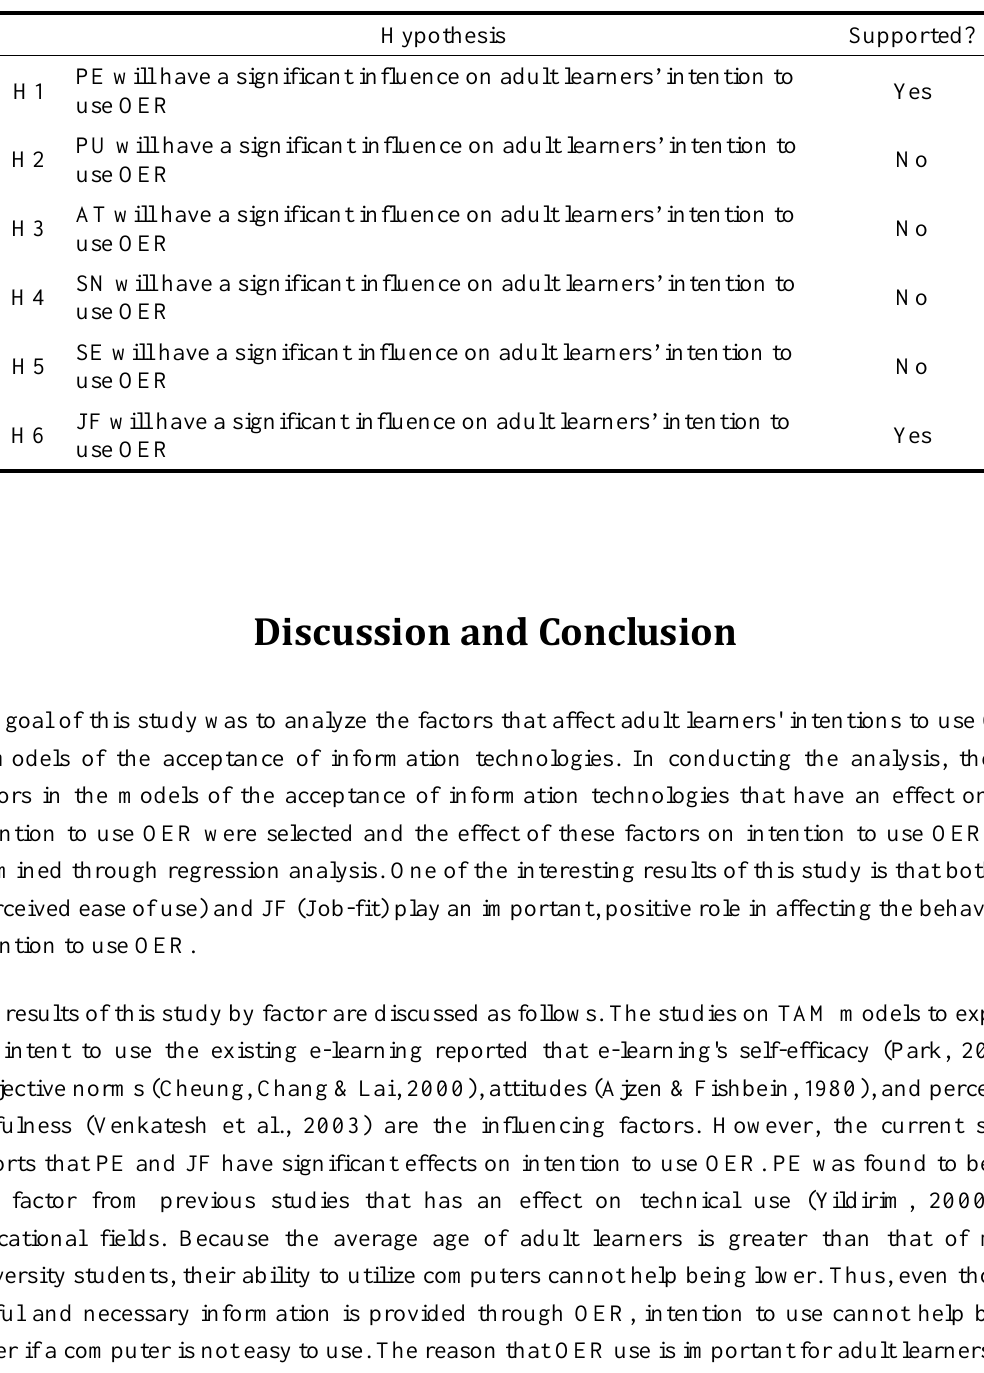
Results of Hypotheses